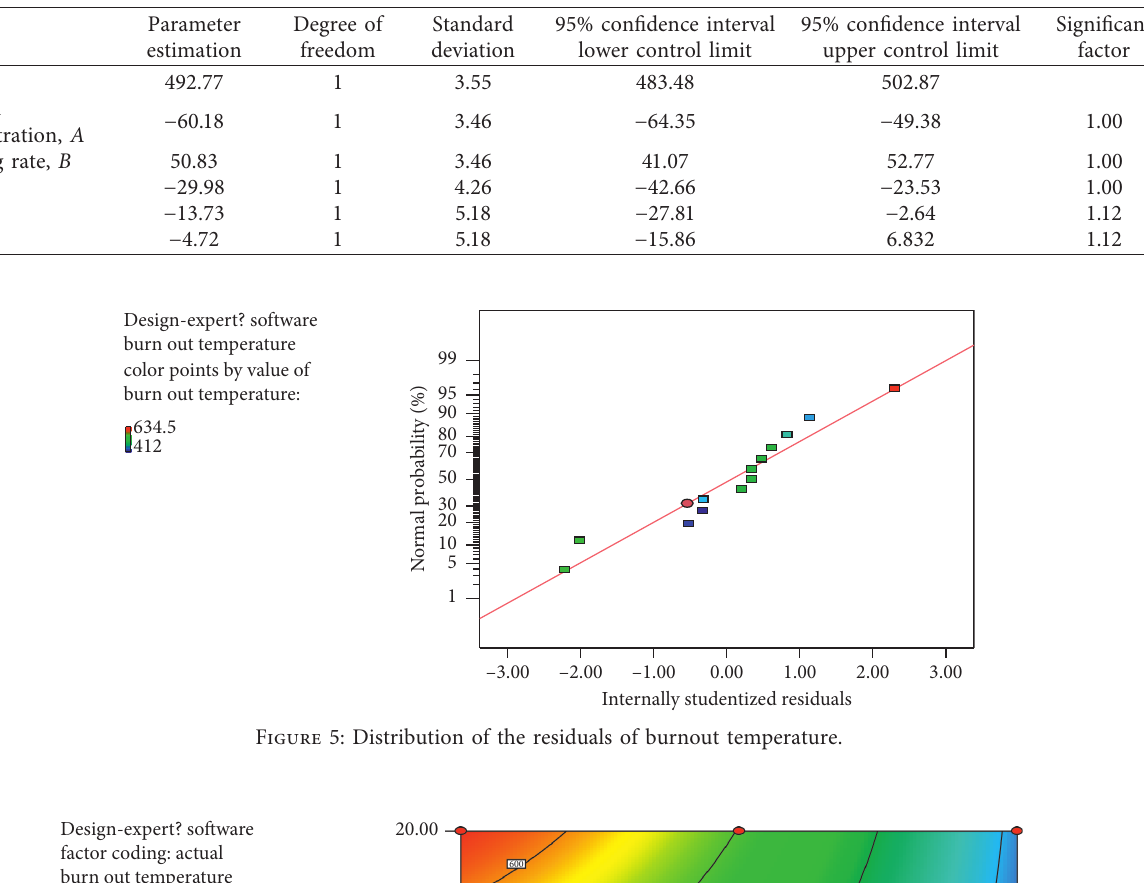
Table 7: The confidence of the two equations for burnout temperature.